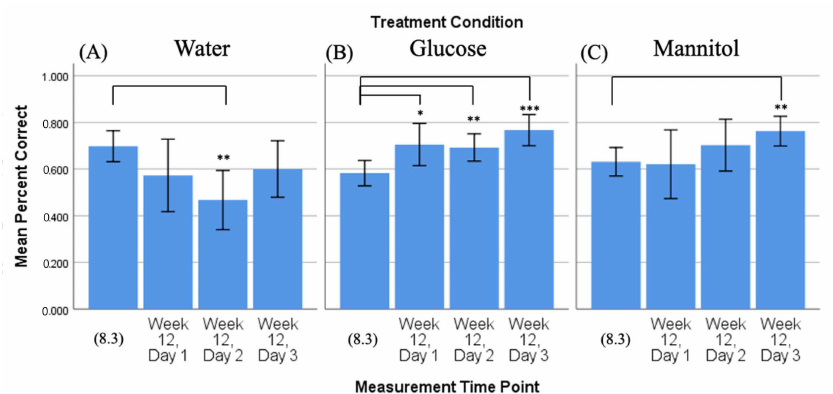
Figure 5. Comparison of 8-week vs. 12-week reversal. Mean percent correct scores (+/ − 95% CI) calculated on 8-week reversal day 3 (8.3) were compared to scores calculated on all three 12-week reversal days for ( A ) water-treated, ( B ) glucose-treated, and ( C ) mannitol-treated fish using individual t -tests. Water-treated fish showed a reduction in correct scores on day 2 (panel ( A ), **). Glucose- treated fish showed significantly more correct scores on all three 12-week reversal days (day 1 p = 0.02; day 2 p = 0.006; day 3 p < 0.001), indicating that these fish were able to find the location of the shoal reward. *,**,*** Asterisks in ( B ) denote significant differences, where the number of asterisks denotes level of significance. Mannitol-treated fish showed significantly increased scores by day 3 ( p = 0.003, (panel ( C ),